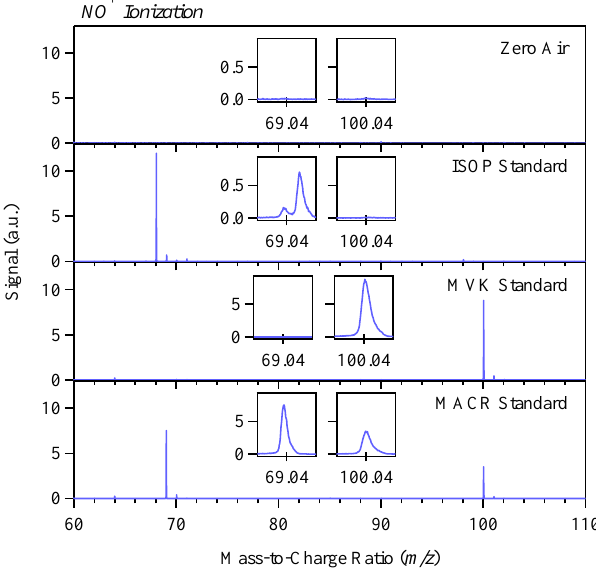
Fig. 2. Mass spectra of zero air, ISOP, MVK, and MACR mea- sured using PTR-TOF-MS with NO + reagent ion. Insets show expansions near m/z 69 and m/z 100, corresponding at m/z 69.0335 to C 4 H 5 O + contributed by MACR and ISOP, at m/z 69.0654 to C 413 CH 8 + contributed by ISOP, and at m/z 100.0393 (cid:5) to C 4 H 6 O NO + contributed by MVK and